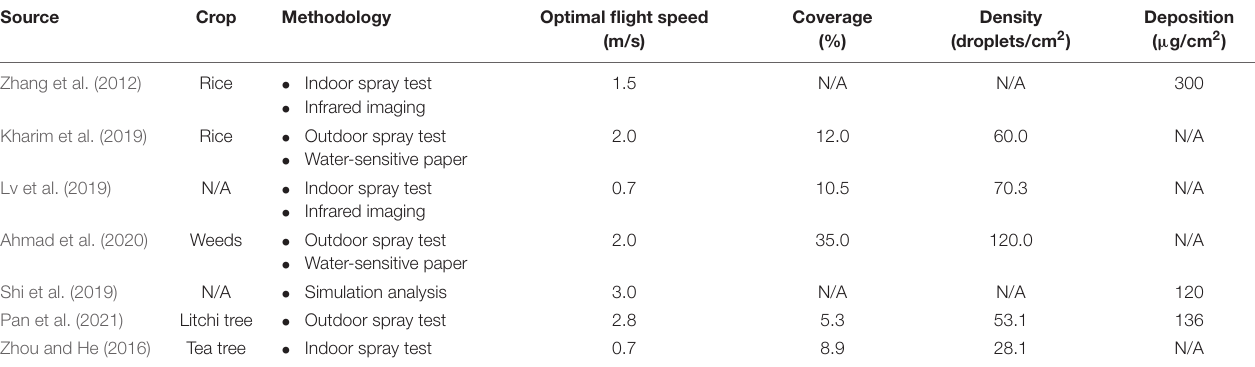
FIGURE 1 | Plant protection UAV and droplet drift phenomenon. TABLE 1 | Published research on the effect of flight speed on droplet deposition.